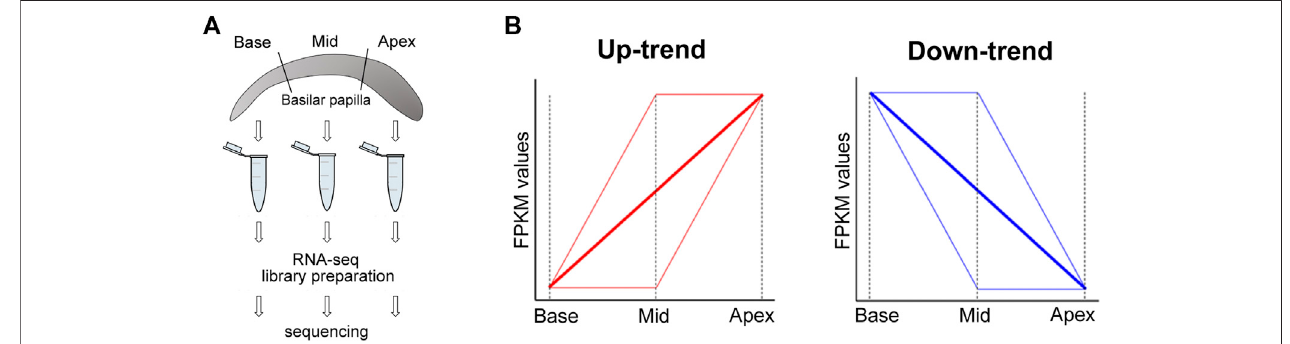
FIGURE 1 | Sample preparation and gene categorization. (A) Chick cochlea sample preparation for RNA-seq. Samples are collected and prepared from three regions (base, mid, apex) of the cochlea (B) Up-trend genes and Down-trend genes are categorized according to their FPKM value changes along the tonotopic axis (from base to